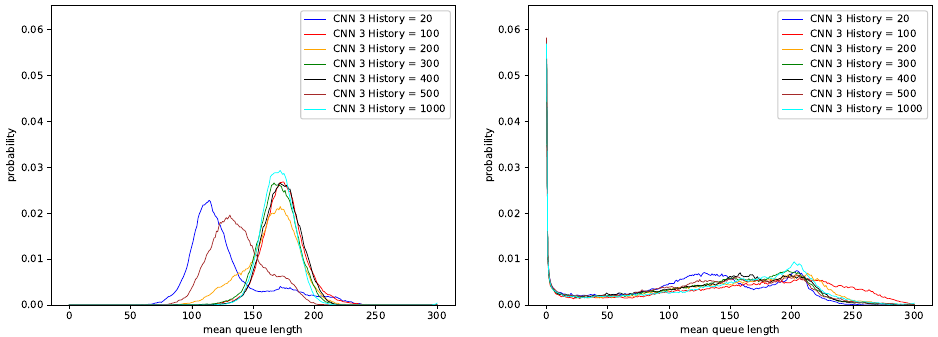
Figure 7. Distribution of queue length obtained for CNN controller trained using data regarding three PI α controllers, H = 0.5 ( left ), H = 0.9 ( right